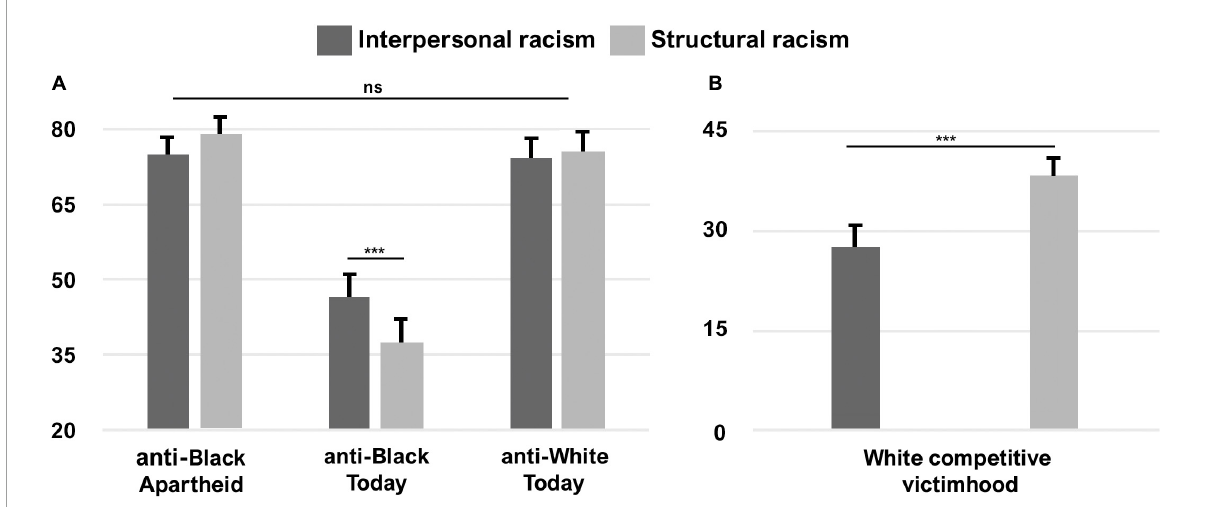
FIGURE1 (A) Study 1 White participants’ perceptions of anti-Black interpersonal and structural racism during apartheid and today, and anti-White interpersonal and structural racism today. (B) Perceptions of competitive victimhood (anti-White racism today minus anti-Black racism today) were greater for structural than interpersonal racism. Error bars indicate standard error of the mean. *** p < 0.001. Panel (A) is reprinted by permission from Springer Customer Service Centre GmbH: Springer Nature, Affective Science (Fourie and Verwoerd, 2022). ns = not